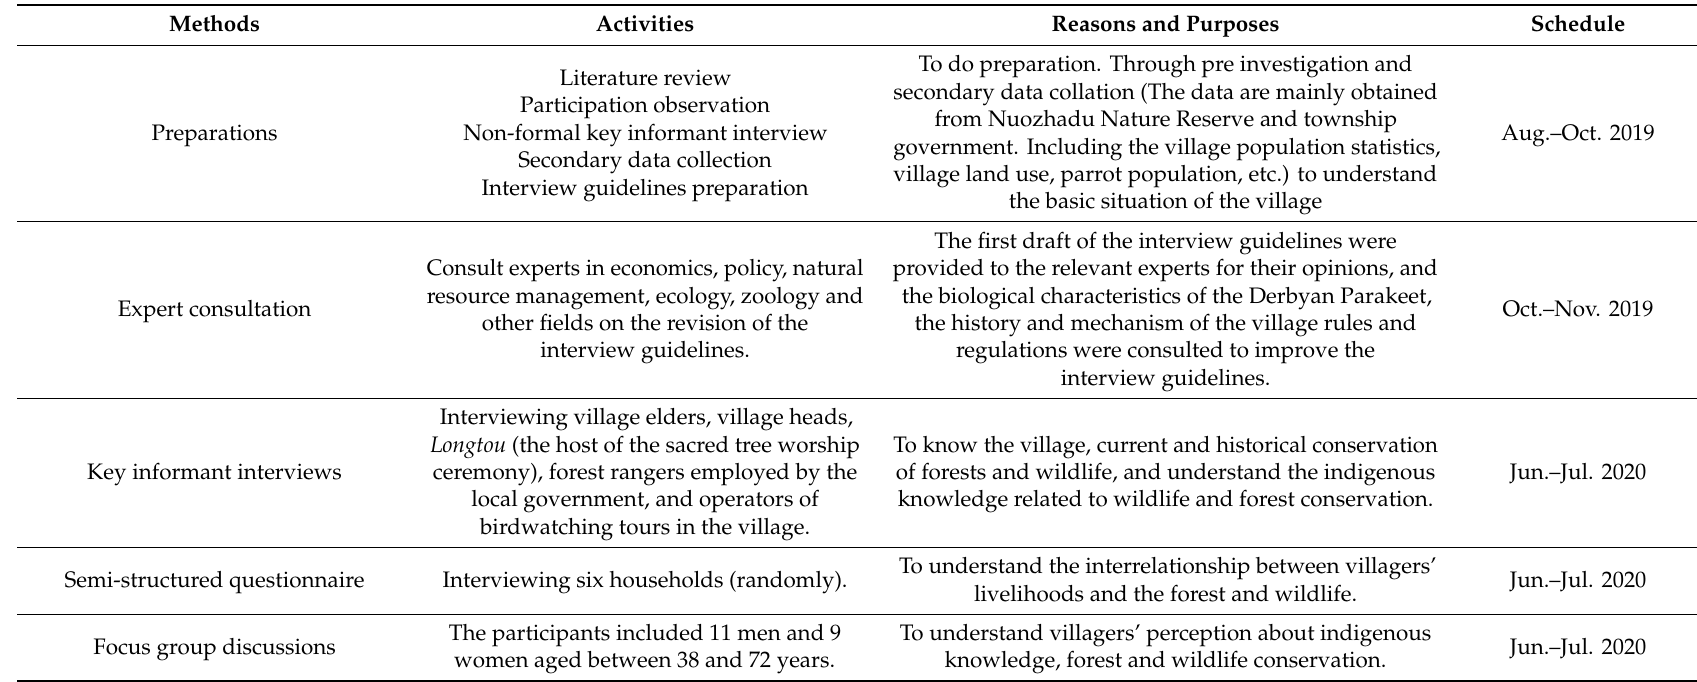
Table 1. Research schedules, activities, and